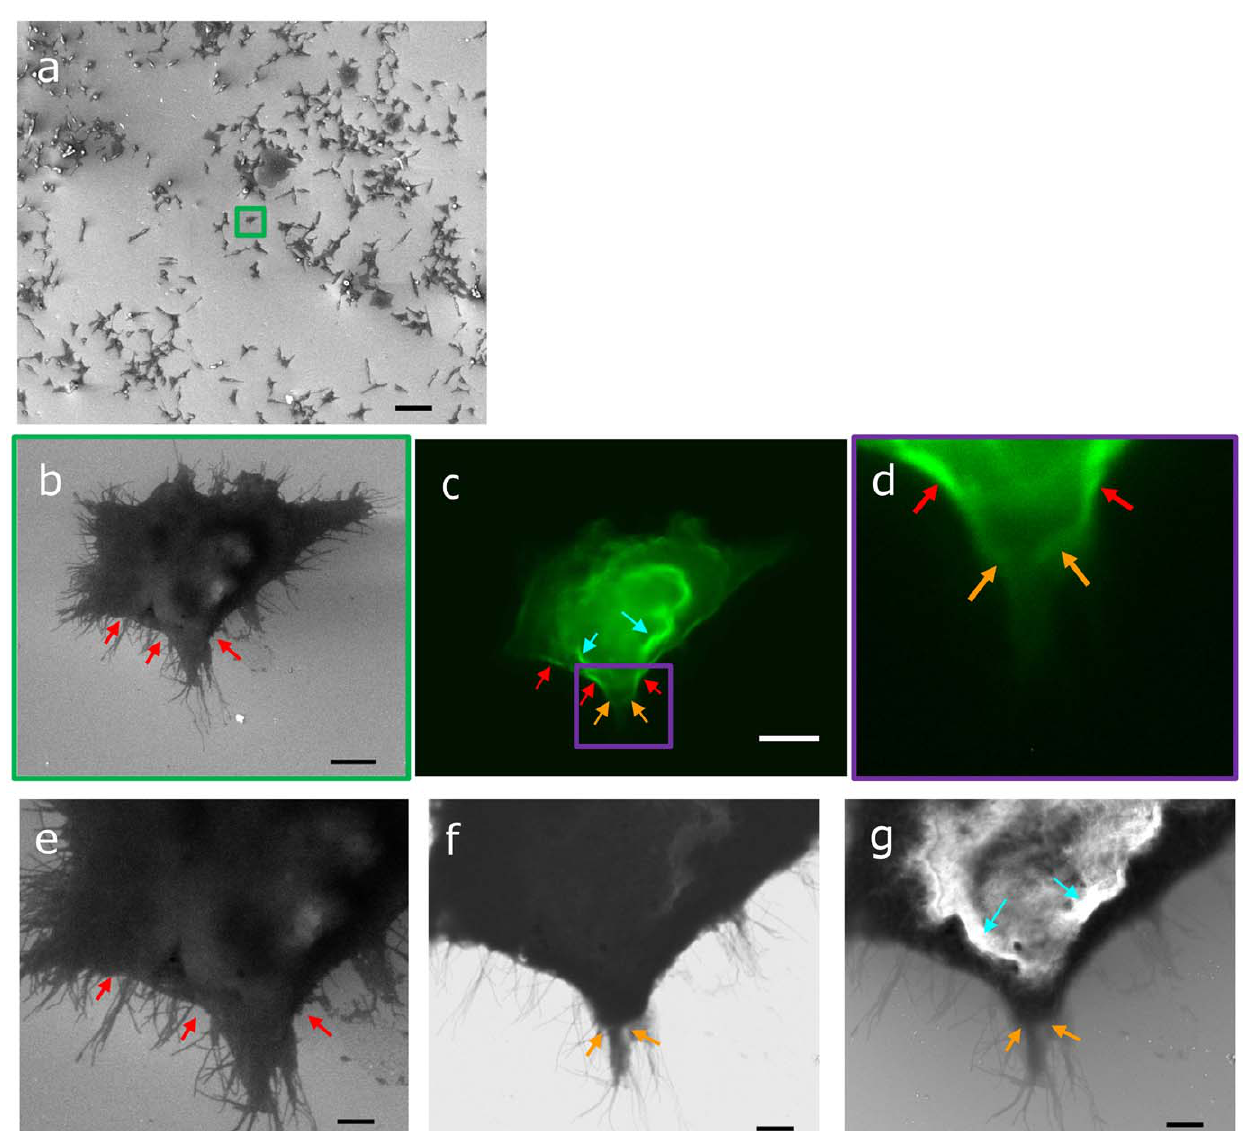
Figure 3. SCLEM inspection procedure with Cortactin labeled adenocancerinoma cells. (a) After mounting the sample and vacuum pumping of the SEM chamber, a low-magnification image in SEM mode is taken to inspect surface coverage and position the sample stage. (b) An isolated cell is identified and the SEM focus is fine-tuned for high-magnification imaging (c) The fluorescence image is recorded after the marked cell was selected. Based on the spatial variations in cortactin distribution and the structural overview in (b), regions of interest are identified for high- magnification imaging in SEM mode. Blue, red, and yellow arrows indicate different type of regions with a local increase in cortactin density. Corresponding areas are also marked in the SEM images. (d) SE image recorded at 20keV of the region of interest identified in (c). The cortactin-rich areas marked with red arrows are directly neighboring regions with larger extrusions and high density of tentacles (e) BSE image recorded at 5keV. (f) SE image at 5keV reveals the details in surface topography. It can be clearly seen that the blue marked cortactin-rich regions located in the cell interior correspond to an increase in cell thickness. The cortactin-rich regions marked with yellow arrows surround a larger thin lamellar outgrowth with numerous extending tentacles. Typical time involved in such a procedure (sample mounting & pump down – a,b – c – d,e,f) amounts to 20–35 minutes (4 min –5 min –5 min –5–15 min).